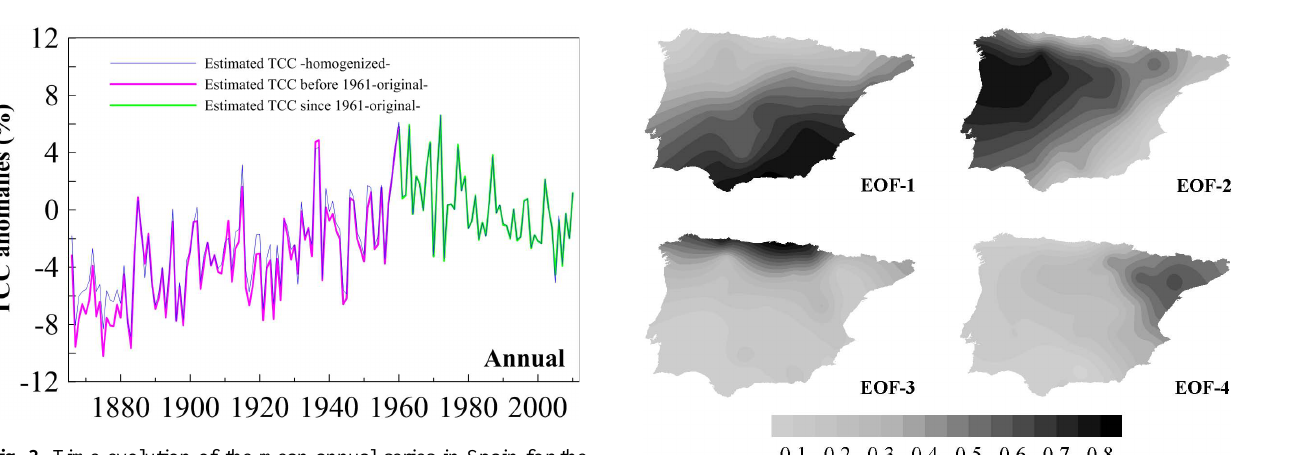
Fig. 3. Time evolution of the mean annual series in Spain for the estimated TCC homogenized series over the 1866–2010 period and for the original estimated TCC series divided in the 1866–1960 and 1961–2010 subperiods. The anomalies are expressed as differences from the 1971–2000 mean.